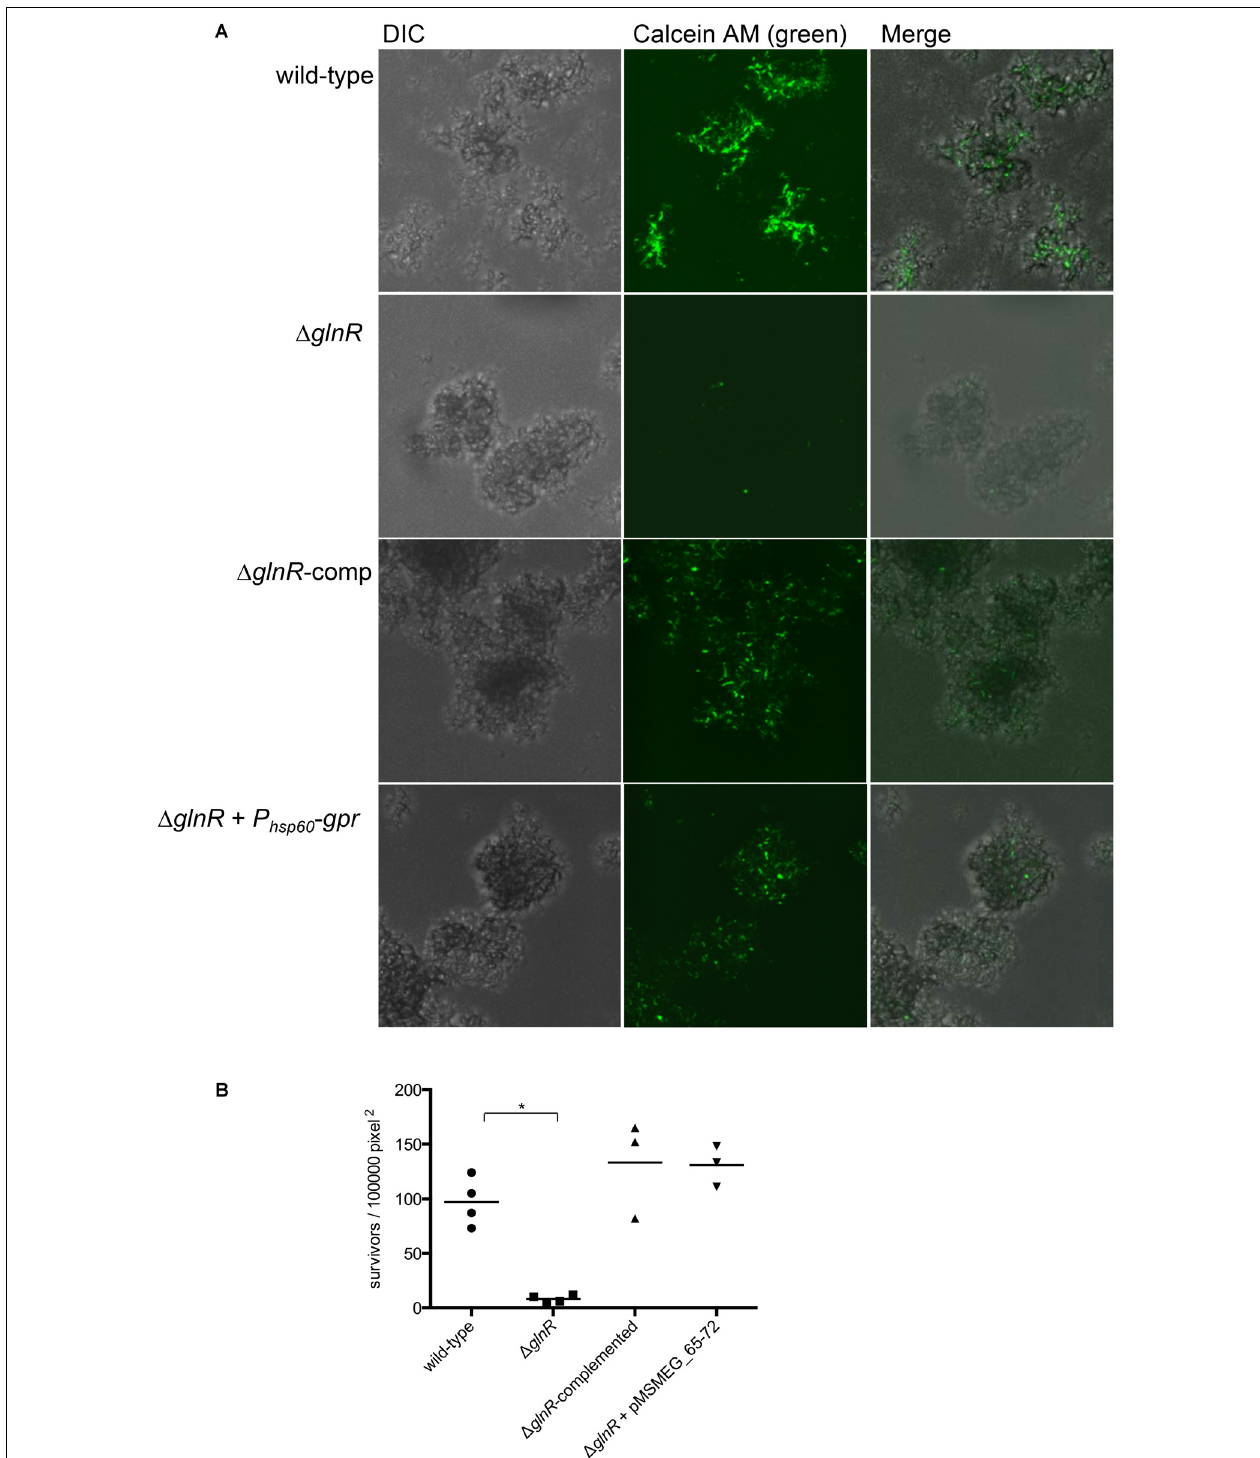
FIGURE 4 | GlnR-dependent expression of gpr induces peroxide resistance in M. smegmatis biofilms. (A) Visualization of peroxide resistant survivors (green) in 4-day biofilms of the indicated strains. Biofilms, cultured in CellASIC Onix microfluidic system perfused with Sauton’s medium, were exposed with the medium containing 20 mM H 2 O 2 for 3 h prior to staining with Calcein AM (1 µ g/mL). Distributions of live cells (green) in colony biofilms were determined from images acquired by confocal microscopy. The micrographs represent maximum intensity projection of green signal across z -stacks analyzed by ImageJ. (B) A summary plot of frequency of green cells in four independent biofilms of wild-type and mutants, and three for the complemented strains. Data represent mean from 3 to 4 independent biofilms of each strain formed in a microfluidic chamber. ∗ denotes p (Mann–Whitney) < 0.05.